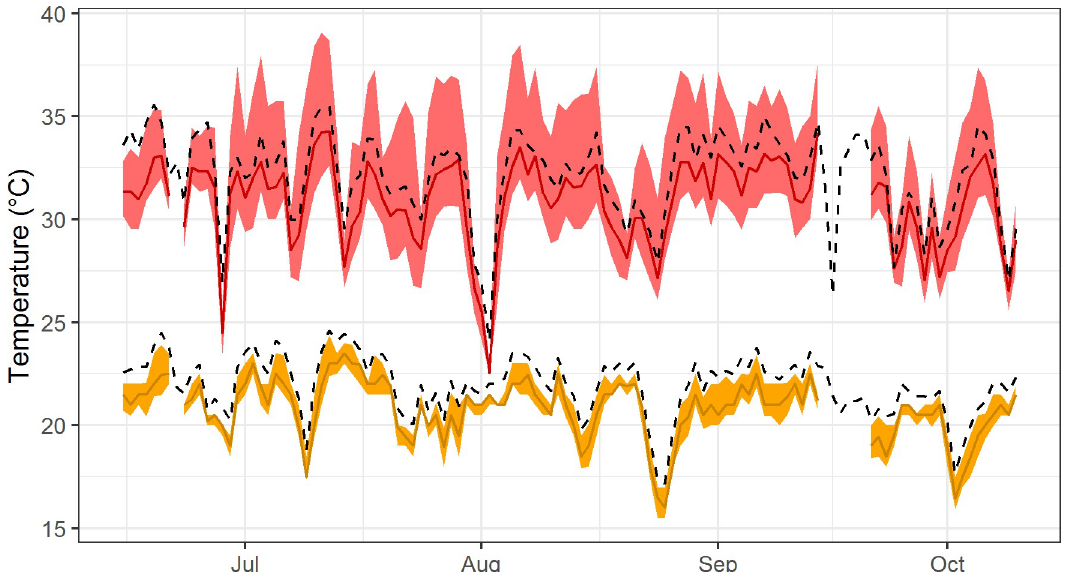
Fig 3. Time series of daily temperature in Athens, GA during 2018. Colored lines represent medians and shaded areas represent the 5%-95% quantile range of microclimate observations for daily minimum temperature (orange) and daily maximum temperature (red). Dashed black lines represent data collected at the University of Georgia weather